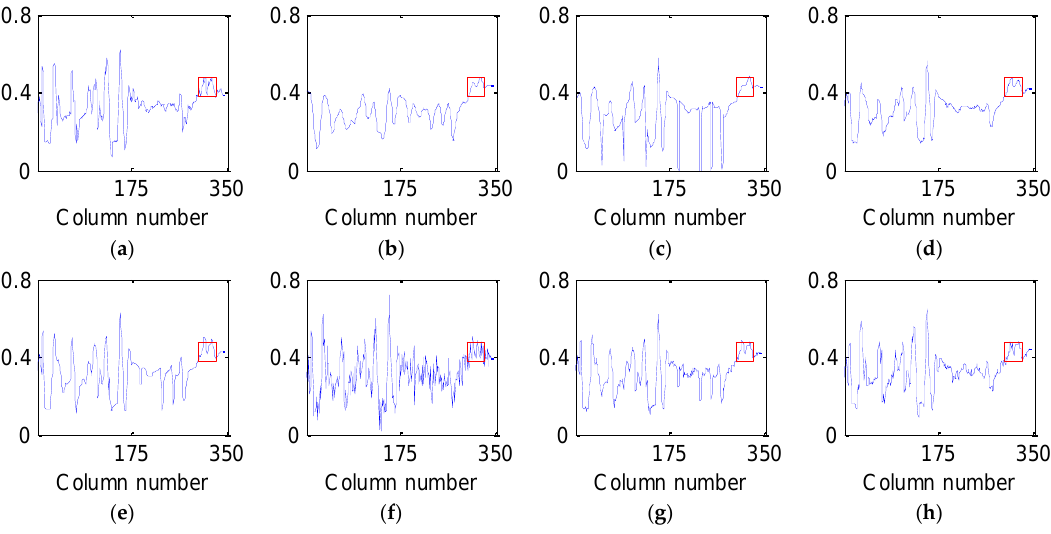
Figure 8. Horizontal profiles of band 95 at pixel (559, 150) before and after denoising: ( a ) clean HSI; ( b ) KSVD; ( c ) BM3D; ( d ) ANLM3D; ( e ) BM4D; ( f ) LRMR; ( g ) DDL3+FT; ( h ) Our method.